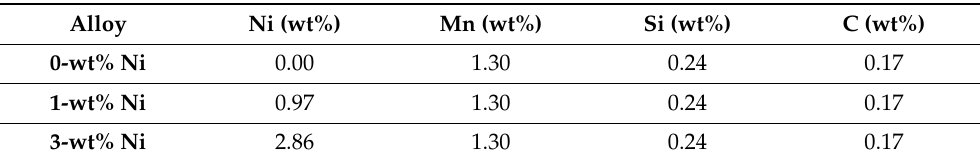
Table 1. Chemical composition of LAS obtained following ASTM E1019-11/CO [23] and ASTM E1479-99/CTP 3101/ICP [24].